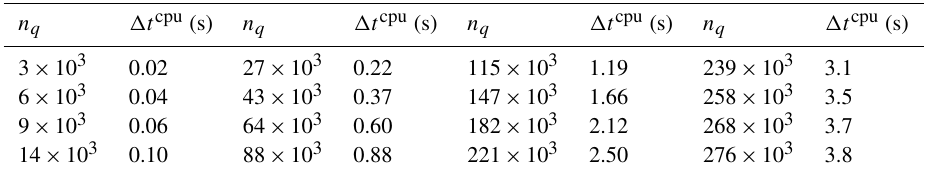
Figure 6. Example of a staggered grid with cells each having volume (cid:49)V . In WFSim, the grid is quadrilateral. Table 1. Mean computation time per simulation time step (cid:49)t cpu vs. number of states n q for the WFSim representation as given in Eq. (21). Computations are performed on a regular notebook with one